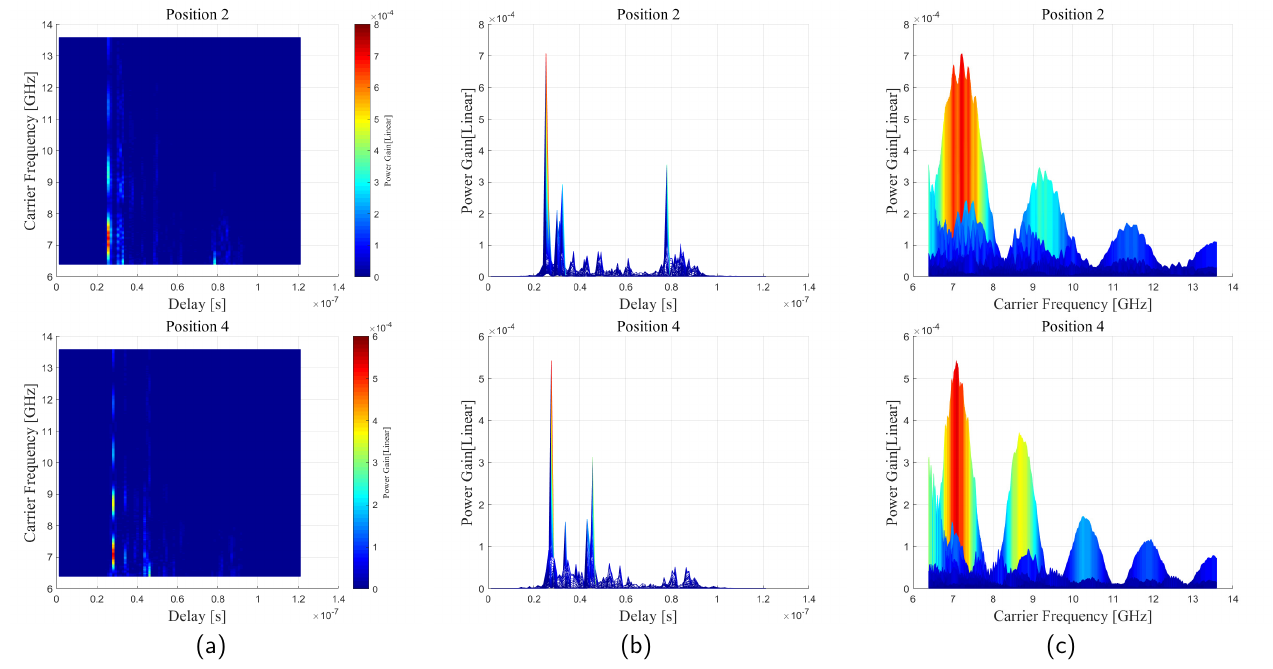
Figure 4. The variations of power with different delays and carrier frequencies at Position 2 and Position 4. ( a ) Power gain with different delays in frequency domain. ( b ) Power gain with different delays. ( c ) Power gain in frequency domain.